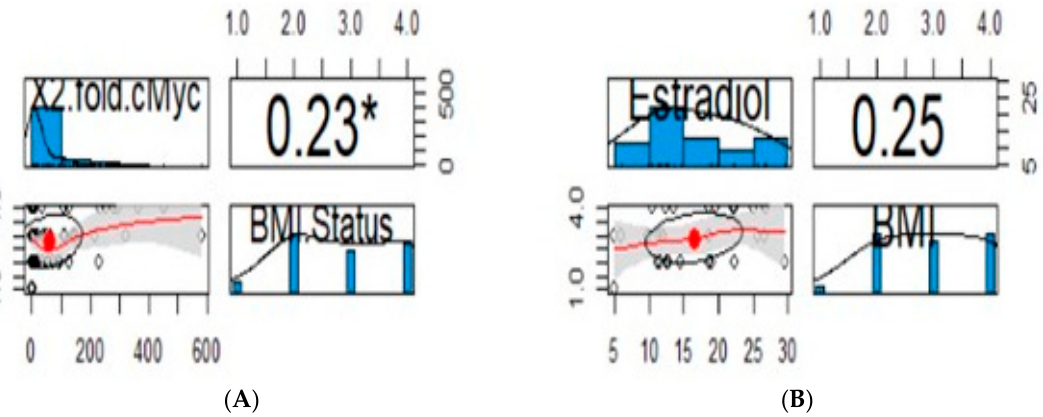
Figure 3. Correlation studies between c-myc, estradiol, and BMI status of breast cancer patients Using Psych package in R software. ( A ): Positive correlation (R = 0.46) exists in c-myc and BMI status. ( B ): Positive correlation (R = 0.50) between estradiol and BMI status (image depicting R 2 value is then converted to R correlation coefficient. * Correlation is significant at 0.01 level (two